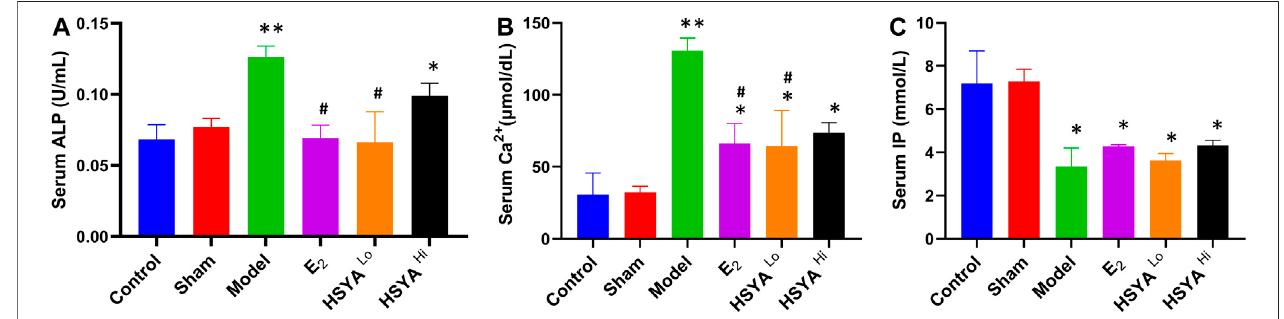
FIGURE 1 | The results of serum (A) ALP, (B) Ca2+, and (C) IP biochemical tests. “ ** ” means p < 0.01, “ * ” means p < 0.05, the difference is statistically signi fi cant compared with the control group. “ # ” means p < 0.05, compared with the model group, the difference is statistically signi fi cant.